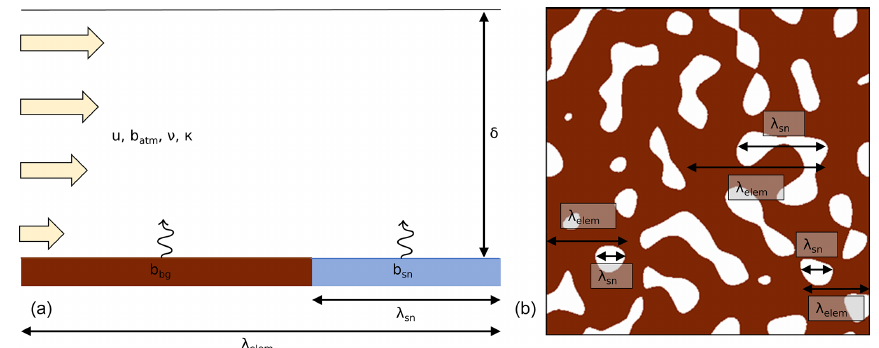
Figure 2. Conceptual situation sketches. Sketches of one snow patch and the adjacent bare ground (i.e., an element) (a) and an exemplary horizontal domain with indicated element and snow patches (b) . The parameters represent the viscosity ν , thermal diffusivity κ , wind speed u , height of the atmospheric surface layer δ , average size of one snow patch element λ elem (consisting of the length of the snow patch λ sn and the adjacent bare ground: λ elem ≡ λ bg + λ sn ), and the buoyancies of the snow b sn and the bare ground b bg